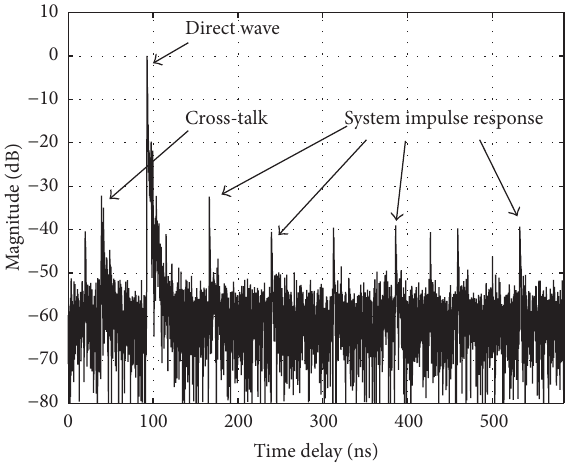
Figure 7: Magnitude of an uncalibrated